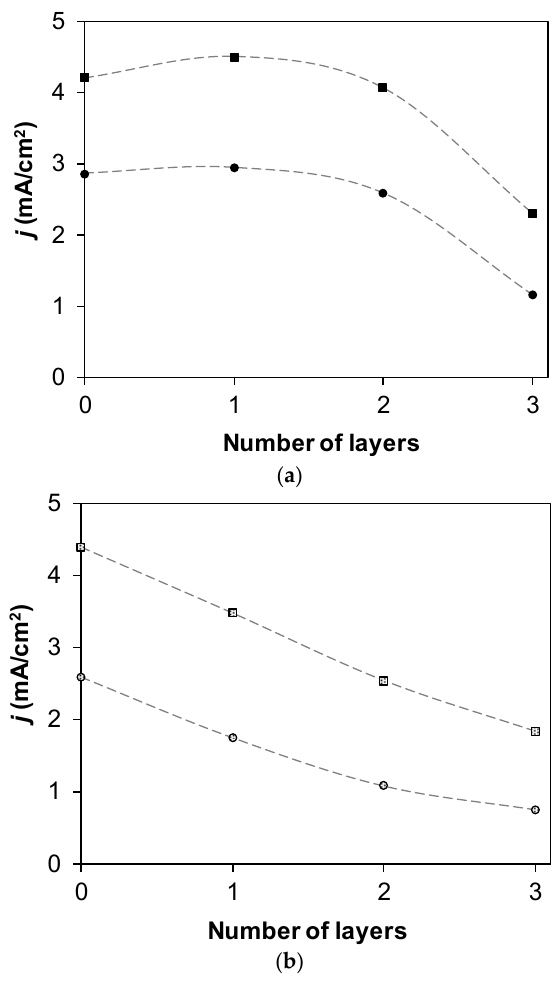
Figure 5. Dependence of experimental limiting current densities ( (cid:1861) (cid:3039)(cid:3036)(cid:3040)(cid:3032)(cid:3051)(cid:3043) , circles) and current densities of transition to the overlimiting current range ( i coupled , squares) on the number of applied layers of polyelectrolyte for AMX-Sb ( a ) and MA-41P ( b ).